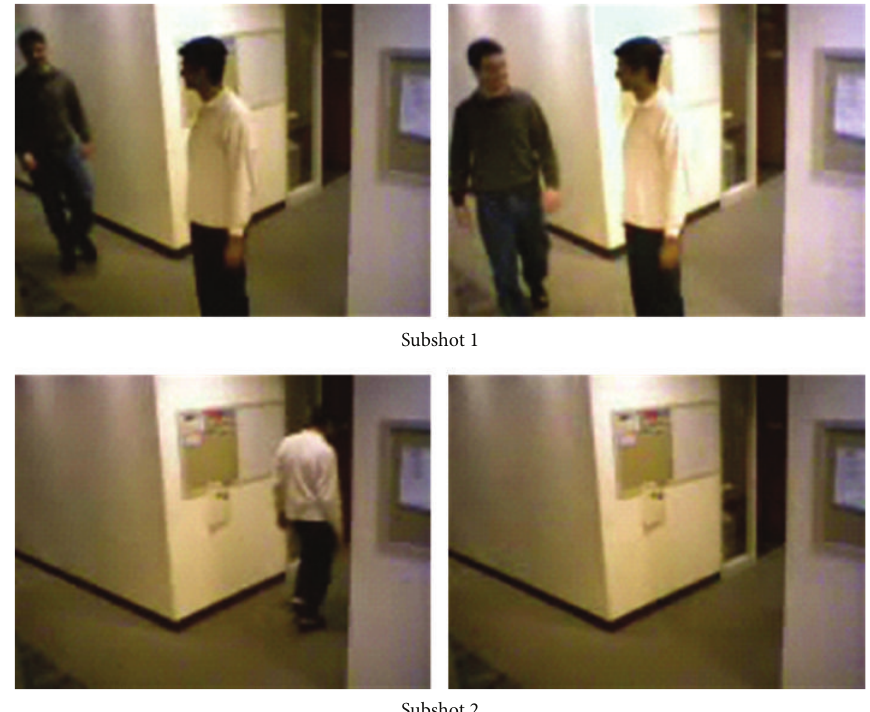
Figure 5: Key-frames extracted from vipmen